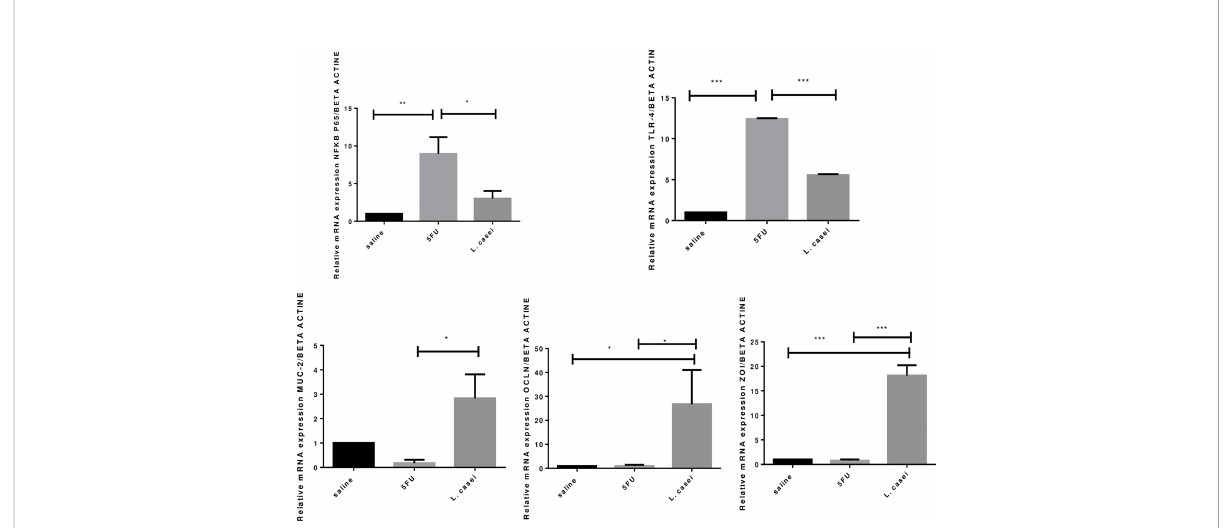
FIGURE 7 Quanti fi cation of gene expression. Beta actin, NFKB-P65, TLR-4, MUC-2 (mucine), OCLN (ocludine), ZO-1 (zonula occluden). Groups: Saline, 5FU (5- fl uorouracil) and L. Casei ( Lacticaseibacillus casei ). * p < 0.05, ** p < 0.01, *** p <